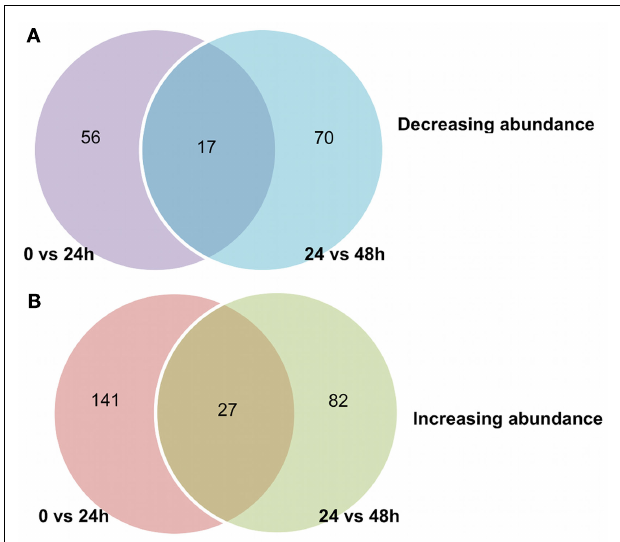
FIGURE 2 | Number of protein spots differentially accumulated during Arabidopsis seed germination. For each time interval, a total number of 475 spots are considered.The normalized volume for each spot was determined in three biological repetitions.The log2 ratio was calculated between 0 and 24h as well as between 24 and 48h.When the spot was not detected in one of the time point, a negligible spot abundance value was arbitrary assigned to calculate the log2ratio. (A) Number of protein spots whose abundance is decreasing (log2 ratio < − 1) between germination sensu stricto (0–24h), radicle protrusion (24–48h) or at both time intervals of seed imbibition. (B) Number of protein spots whose abundance is increasing (log2 ratio > 1) between germination sensu stricto (0–24h), radicle protrusion (24–48h) or at both time intervals of seed imbibition.